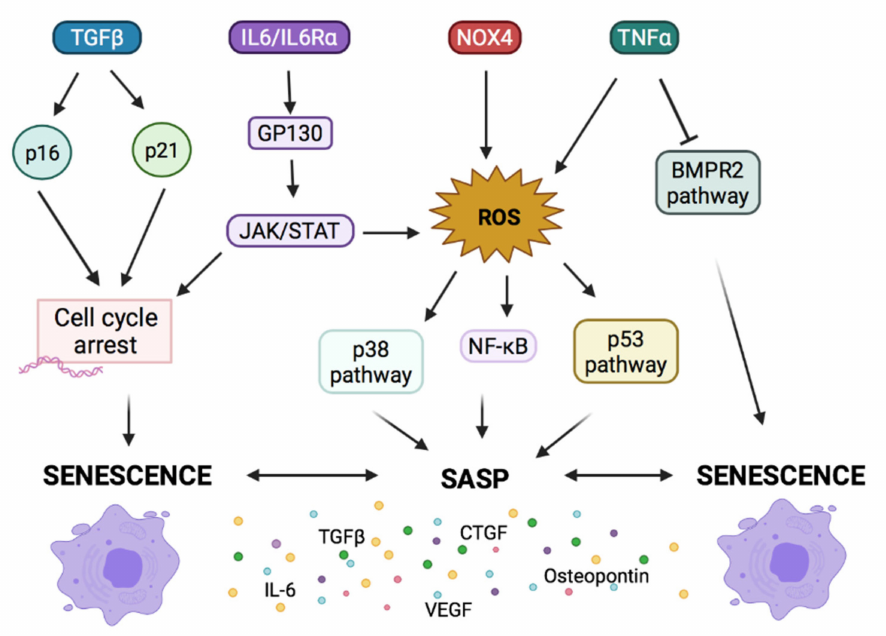
Figure 3. Mechanisms of cellular senescence. TGF β activates the p21 and p16 pathway to stop the cell cycle, which induces senescence. The binding of IL-6 to its unique-receptor IL-6R triggers the homodimerization of GP130. This results in the phosphorylation of Janus kinases (JAK), which phosphorylate intracellular tyrosine residues that serve as docking sites for STAT3. JAK/STAT induces cell cycle arrest and causes the initial generation of reactive oxygen species (ROS), subsequent senescence, and senescence associated secretory phenotype (SASP) (expression of IL-1 α , IL-1 β , IL-6, CTGF, VEGF, TGF β , and osteopontin). NOX4 and TNF α also induce ROS production. ROS can induce senescence and SASP through the p38MAPK/NF- κ B/p53